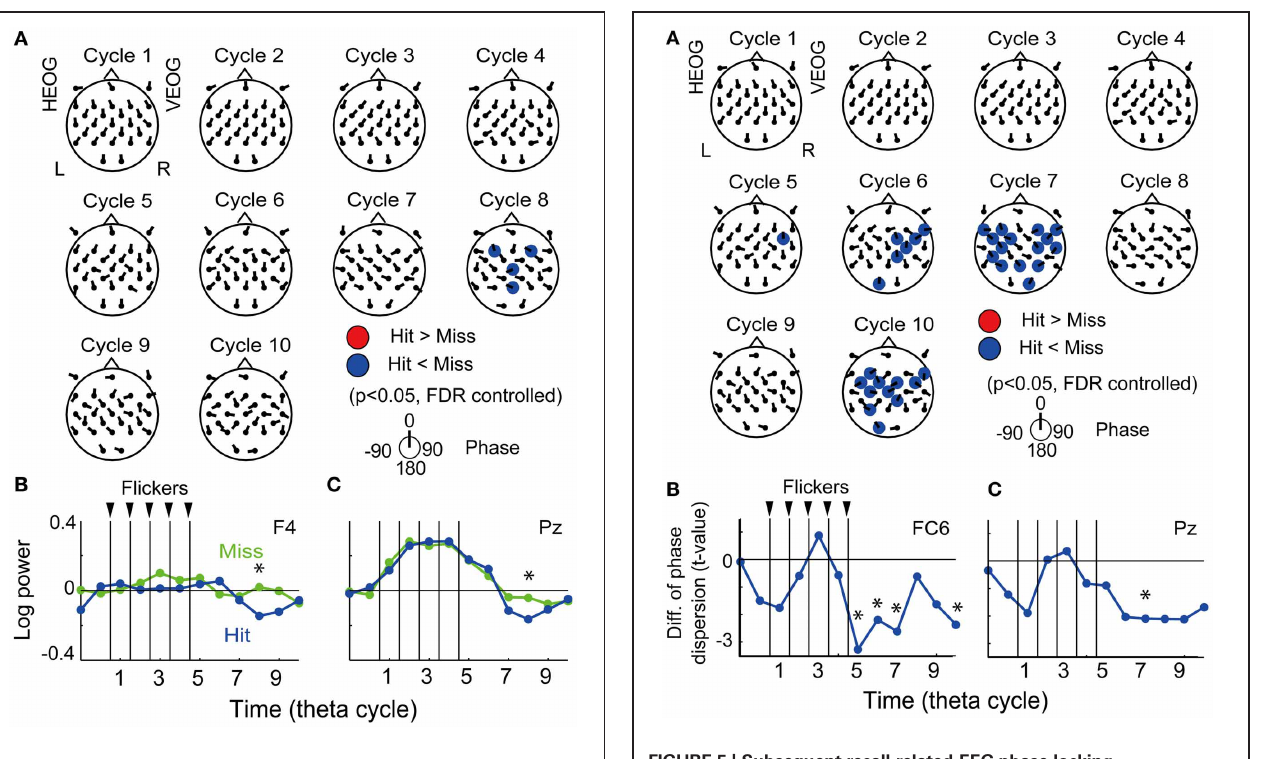
FIGURE 4 | Subsequent recall-related flicker-induced EEG power. (A) Topographical maps of average p -value at each cycle showing difference between EEG power in the Hit condition and that in the Miss condition ( p < 0 . 05, FDR controlled). Direction of arrow at each electrode location indicates a mean EEG phase in the Hit condition against that in the Miss condition. (B,C) Temporal evolution of EEG power against a mean EEG power in Constant condition averaged over all participants (at F4 and P4 electrodes). Blue and green represent EEG power in the Hit condition and that in the Miss condition, respectively. Asterisks indicate significant difference between EEG power in the Hit condition and that in the Miss condition.